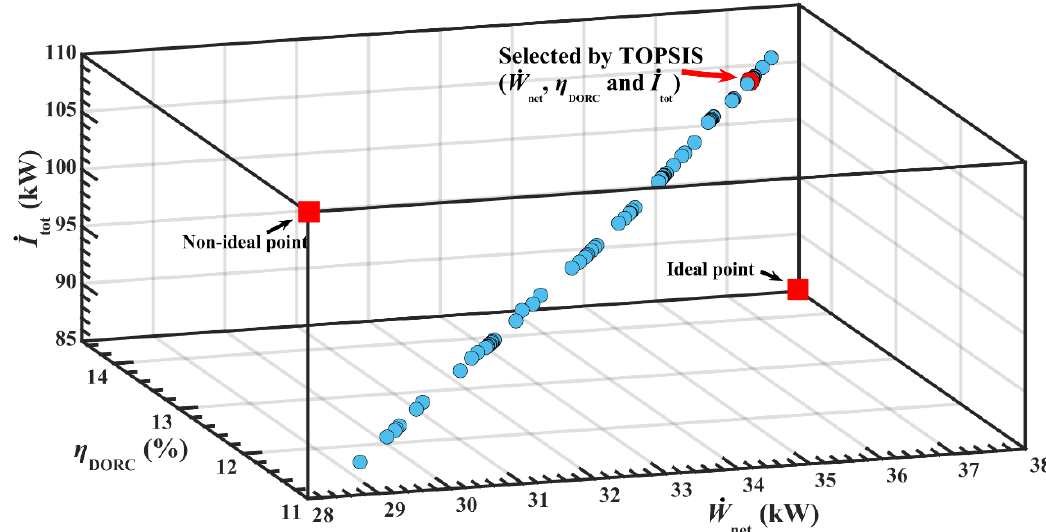
Figure 20. Multi objective optimization and TOPSIS selection.